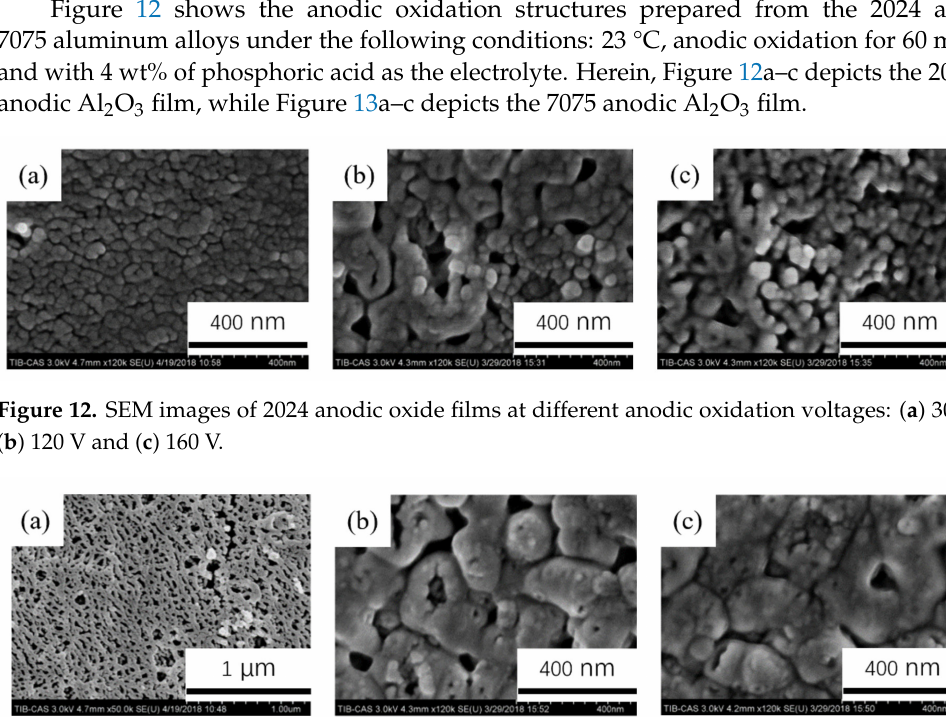
Figure 13. SEM images of 7075 anodic oxide films at different anodic oxidation voltages: ( a ) 30 V; ( b ) 120 V; ( c ) 160